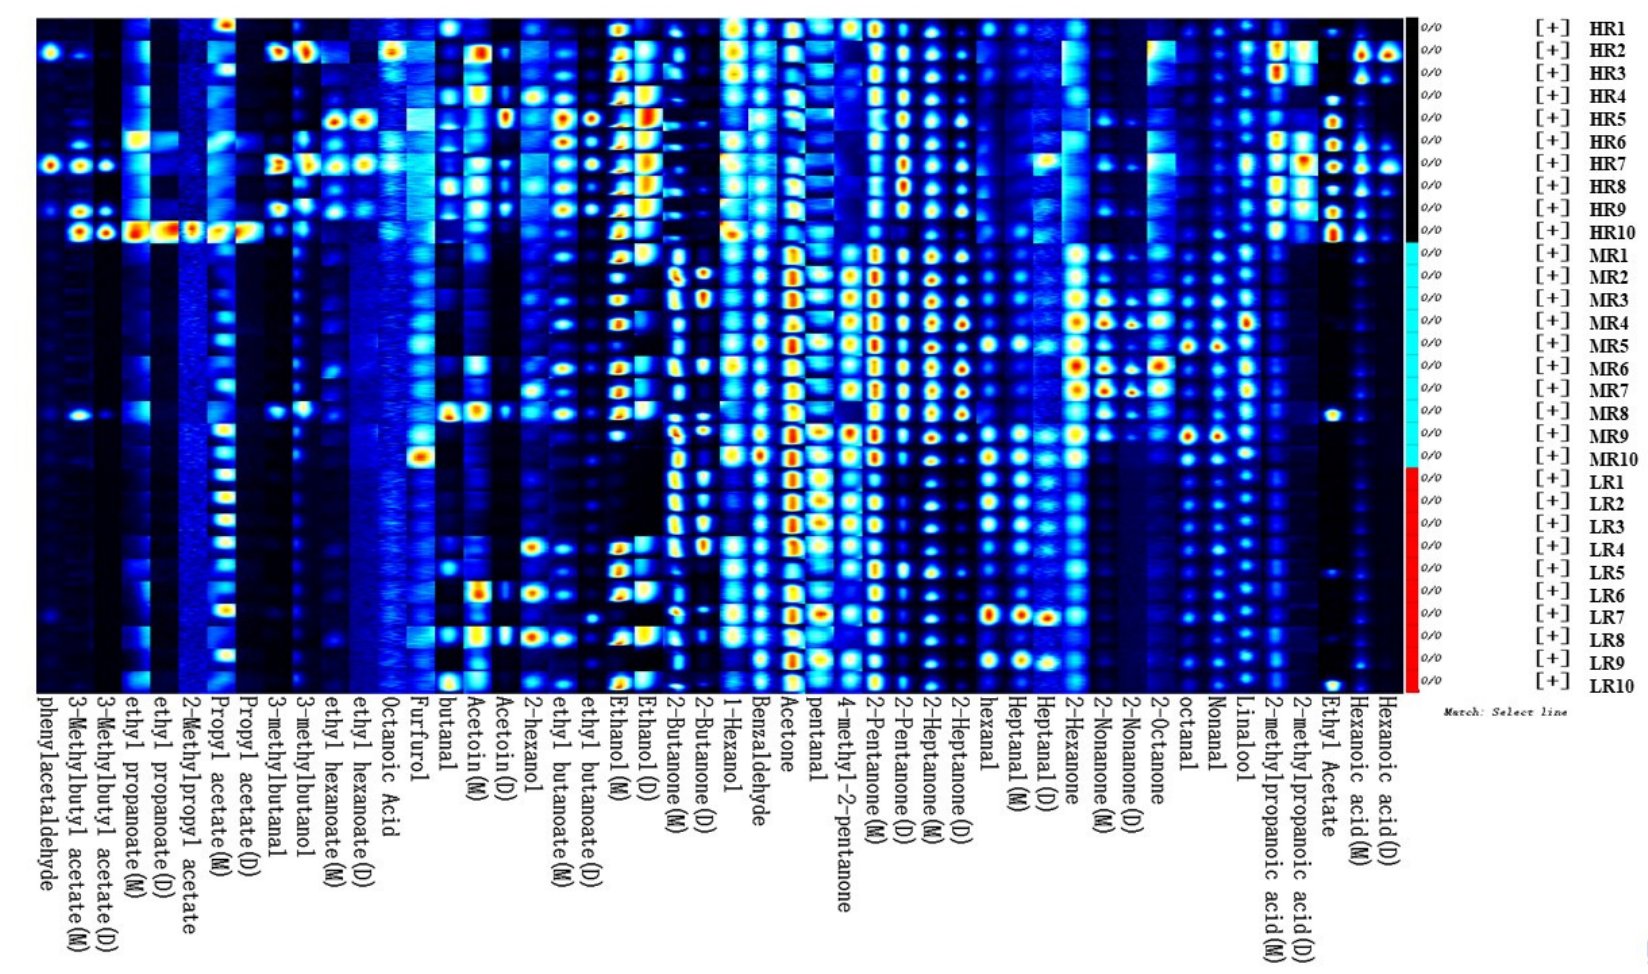
Figure 2. Gallery Plot of different treatments of raw milk by GC–IMS.